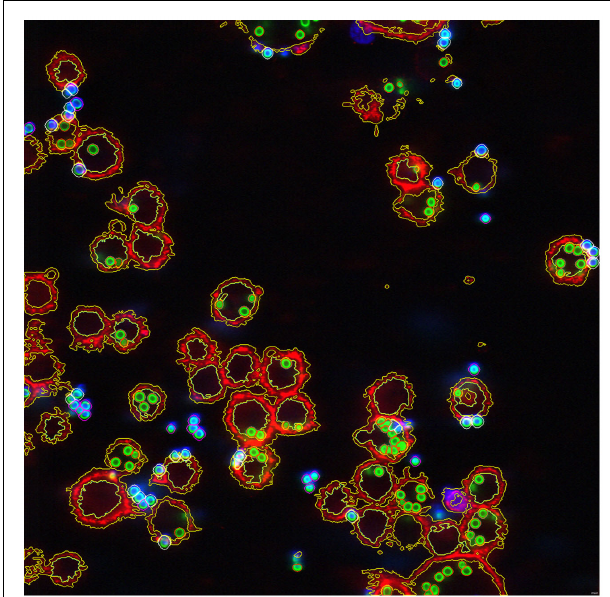
FIGURE 1 | Image of the phagocytosis assay showing all conidia and macrophages after segmentation and classification. Exterior non-adherent conidia outlined in magenta, adherent conidia outlined in white, interior conidia outlined in orange, and macrophages outlined in yellow. ( Taken from Mech et al., 2011.)